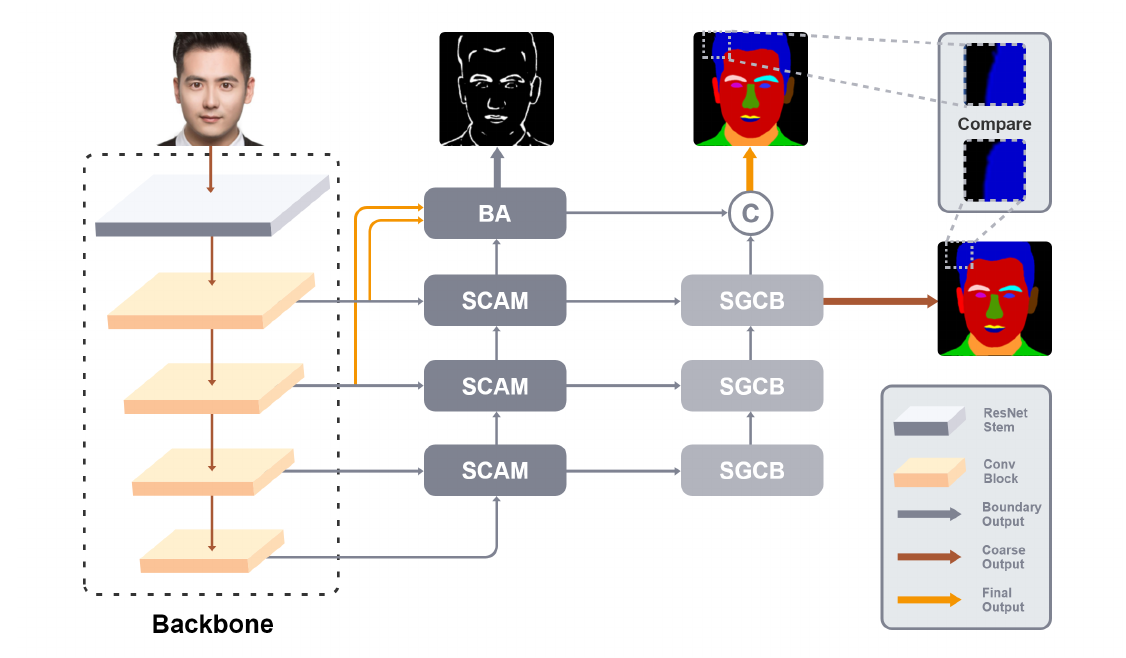
Figure 2. Diagram of our effective hierarchical aggregation network (best viewed in color). “C” stands for channel-wise concatenation. “SCAM” denotes stage contextual attention mechanism. “SGCB” denotes semantic gap compensation block. “BA” denotes boundary-aware